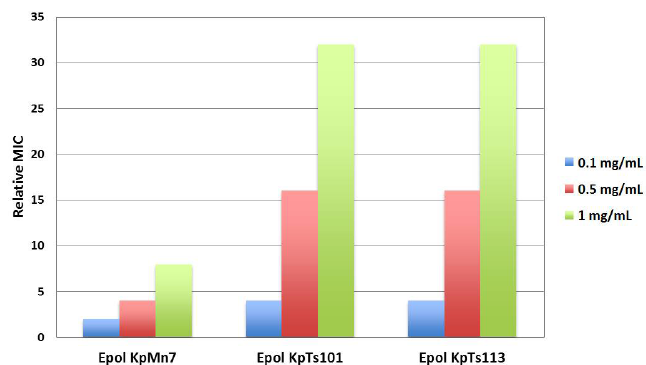
Figure 5. Relative MIC values for BMAP-27 against Escherichia coli ML-35 in the presence of different